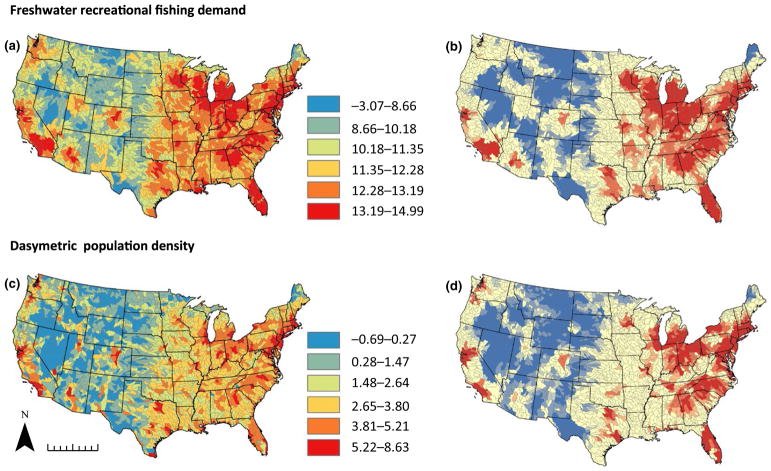
Raw data (a, c) and hotspot analysis (b, d) for freshwater recreational fishing demand (a, b) and dasymetric population density (c, d). Both predictors have been mean-centred and standardized. Colour scale shown is for raw data only; colour scale for hotspot analysis is as in Figure 2. All data are summarized at the eight-digit HUC. Scale bar at bottom left indicates 1,000 km. [Colour figure can be viewed at wileyonlinelibrary.com]